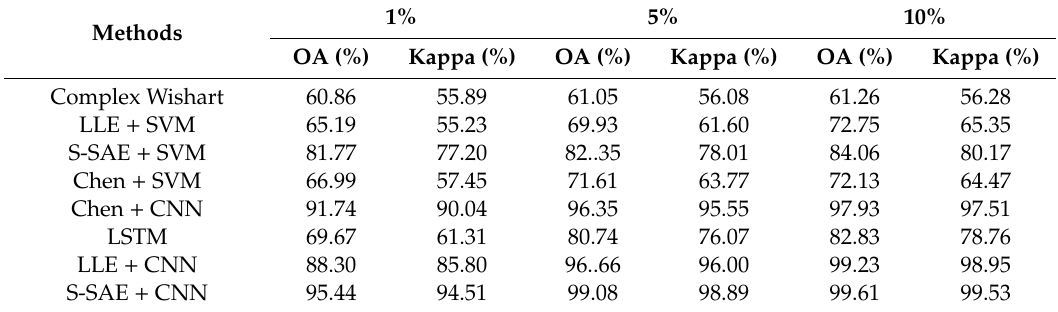
Table 7. Classification accuracy with di ff erent methods and training ratios for the Indian Head